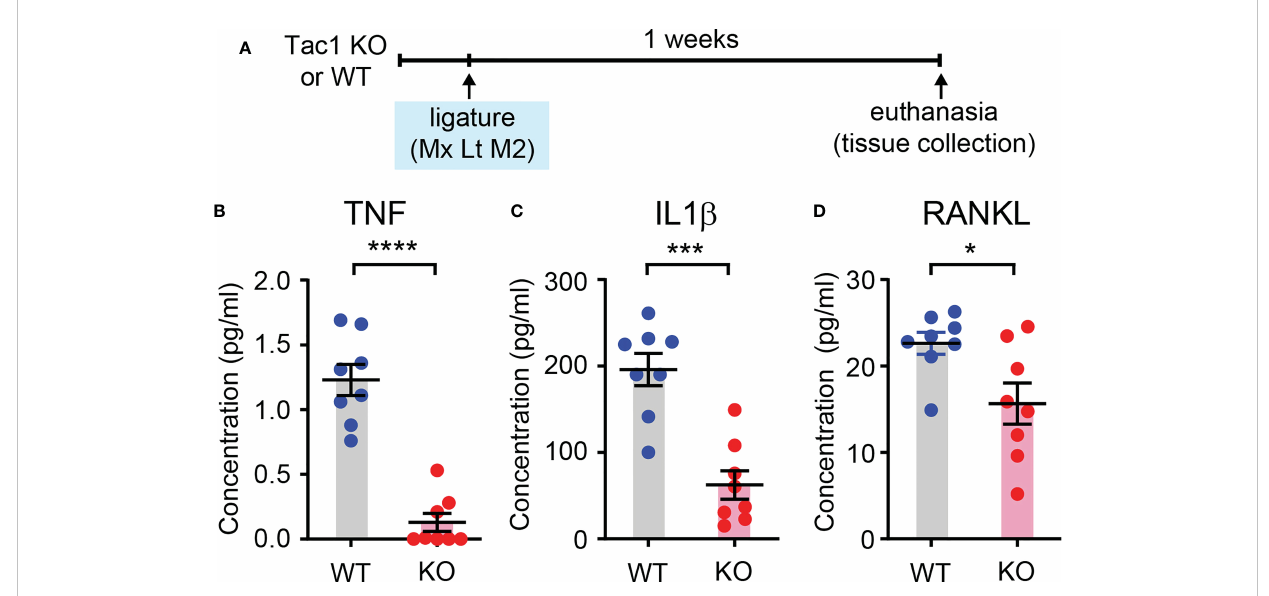
FIGURE 6 SP knockout decreases proin fl ammatory cytokines in periodontium. (A) Time course of the experiment. Luminex assay for measuring tumor necrosis factor (TNF; B ), interleukin 1 b (IL1 bg C ) and receptor activator of nuclear factor kappa- Β ligand (RANKL; D ) in periodontia from WT or Tac1 KO mice. The mice were euthanized two weeks after placing the ligature. *p<0.05; ***p<0.0005; ****p<0.0001. N=8 per